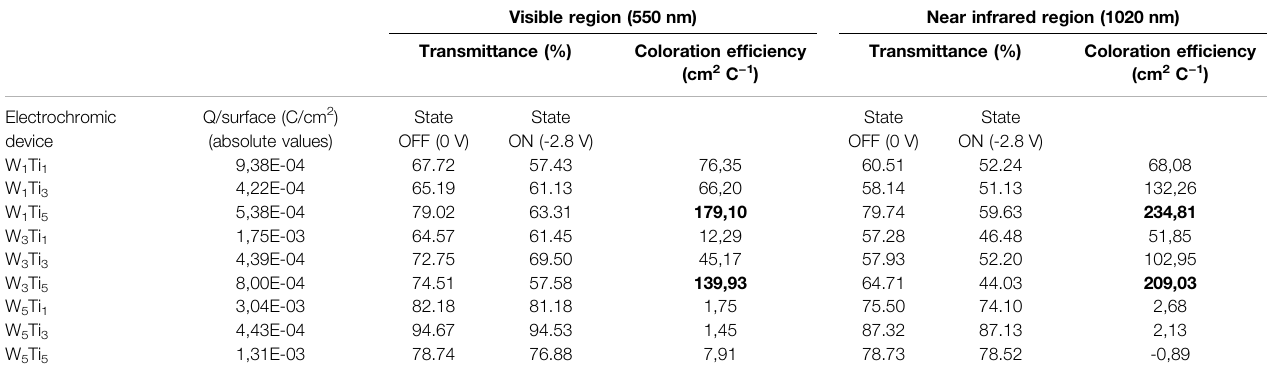
TABLE2| TransmittancesofthestatesOff(0.0 V)andOn( − 2.8 V)andcolorationef fi ciencyvaluesinthevisibleregion( λ =550 nm)andNearInfraredregion( λ =1020 nm)of the following electrochromic devices: W 1 Ti 1 , W 1 Ti 3 , W 1 Ti 5 , W 3 Ti 1 , W 3 Ti 3 , W 3 Ti 5 , W 5 Ti 1 , W 5 Ti 3 , and W 5 Ti 5 (W x Ti y , where W and Ti indicate the WO 3 and TiO 2 electrodes, respectively and the subscripts x and y indicate their annealing temperature expressed in hundreds, respectively) (see Figure 4 ). Visible region (550